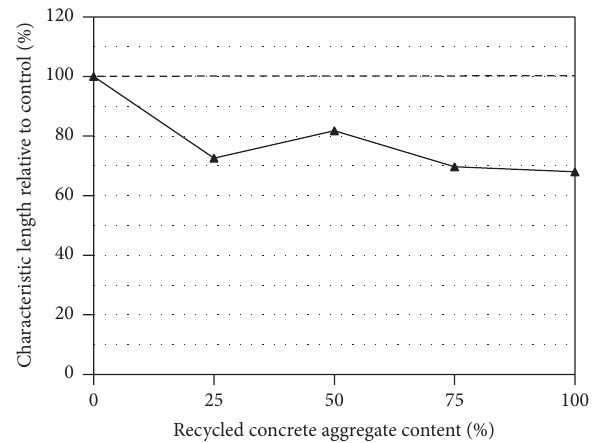
Figure 8: Influence of RCA coarse aggregate content on character- istic